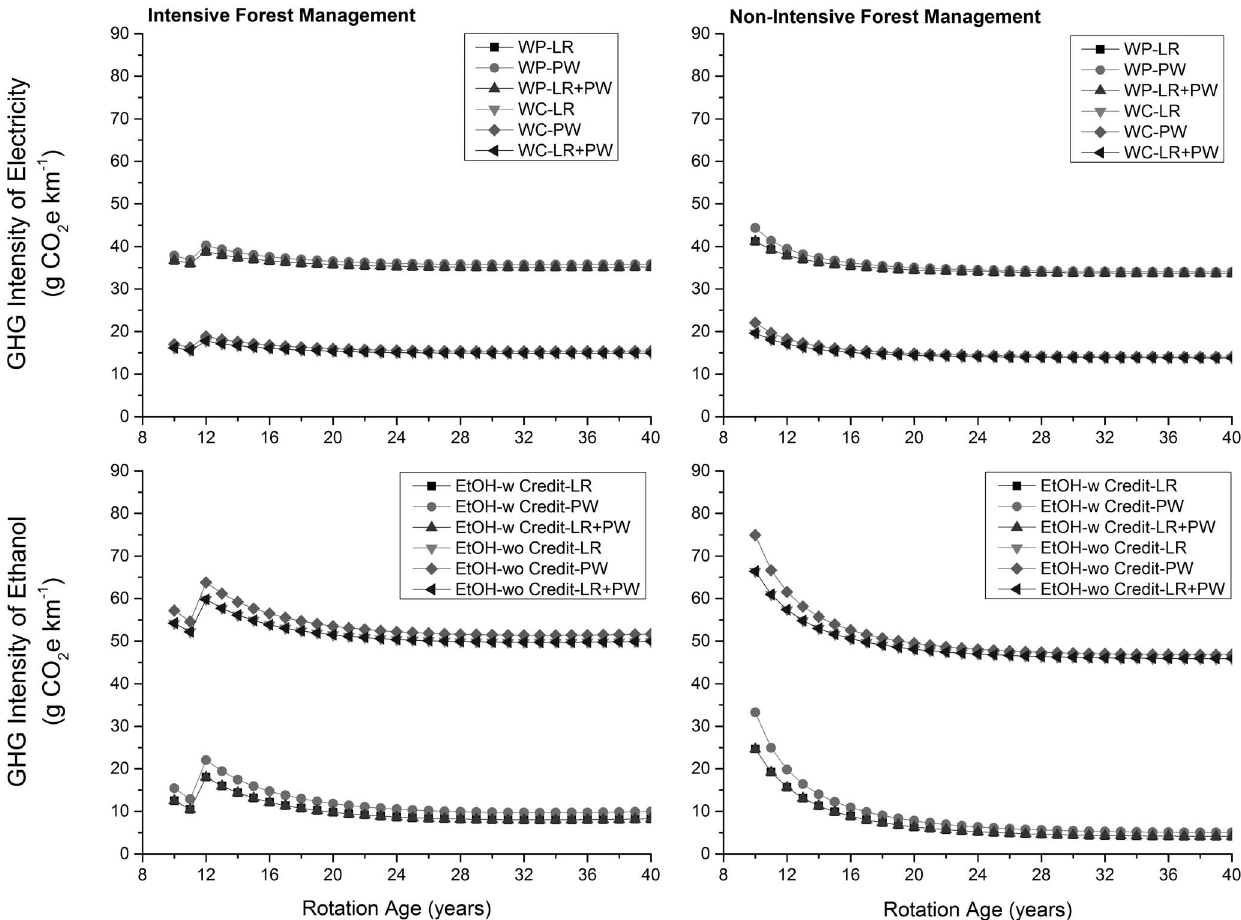
Figure 7. GHG intensity of energy products at the consumption level. LR: logging residues; PW: pulpwood; WP: wood pellets; WC: wood chips; w: with income from cogenerated electricity; wo: without income from cogenerated electricity.